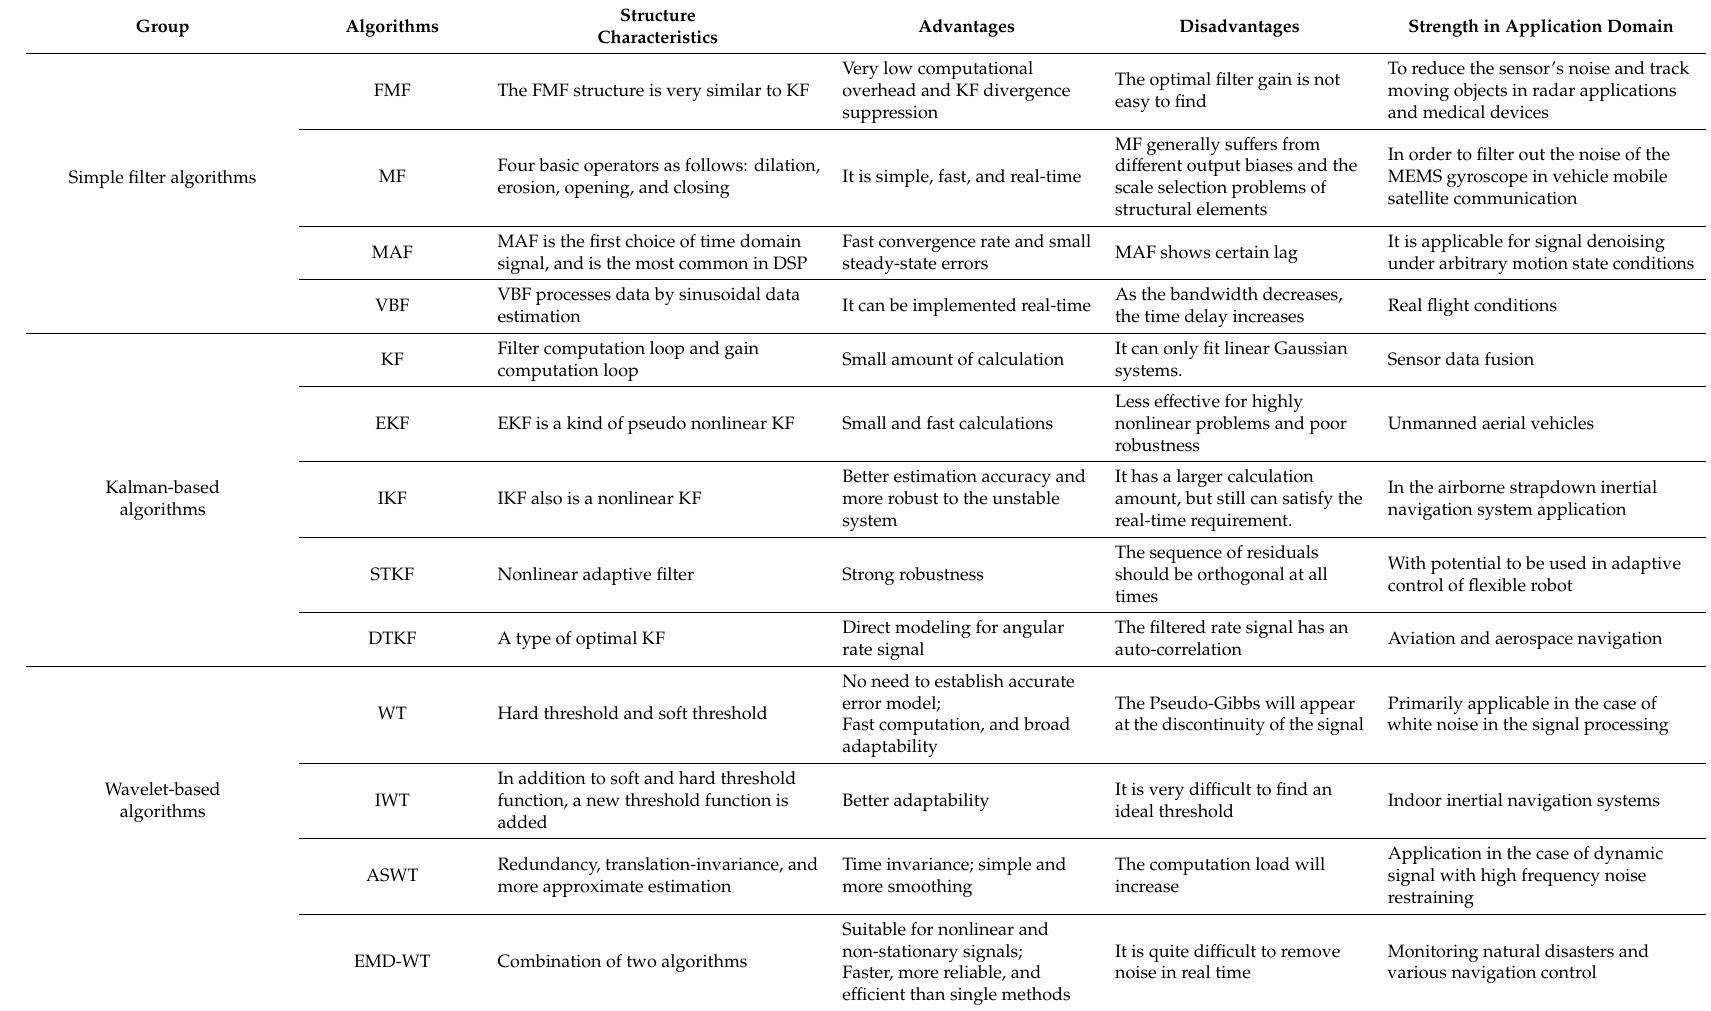
Table 2. Comparative analysis of individual algorithms and their